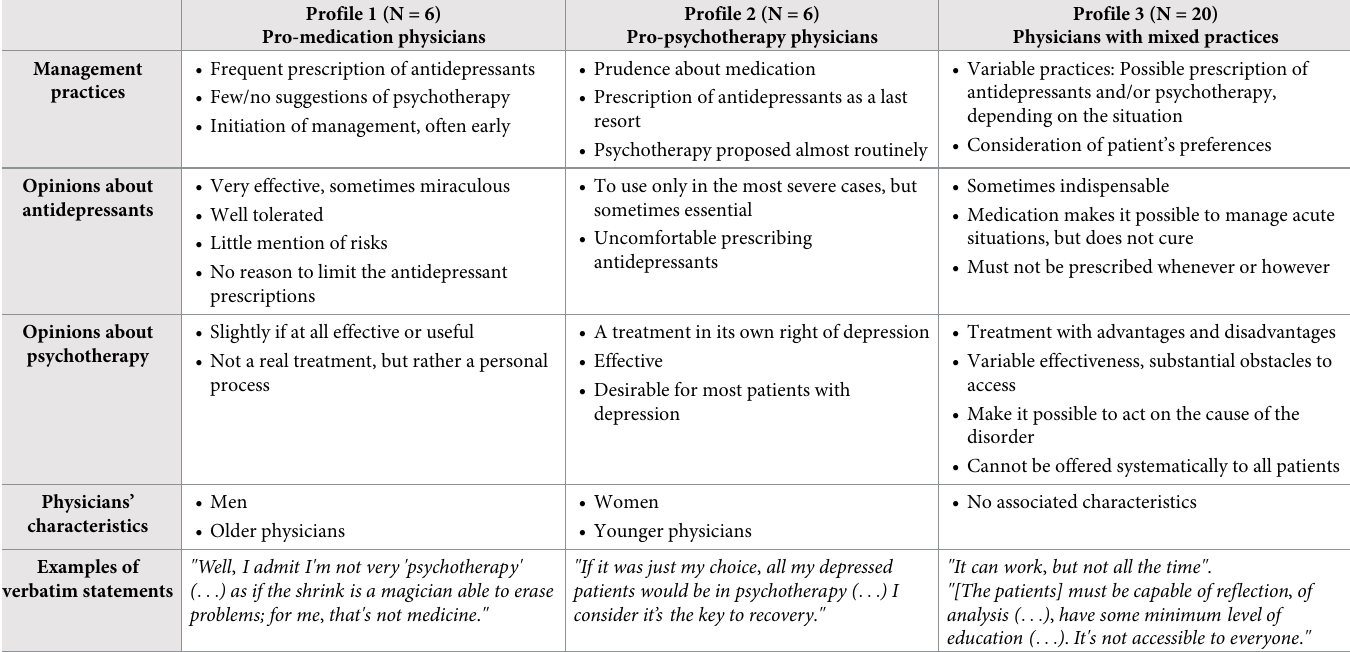
Table 3. Profiles of physicians as a function of their practices and opinions related to psychotherapy and antidepressants. Profile 1 (N = 6) Pro-medication